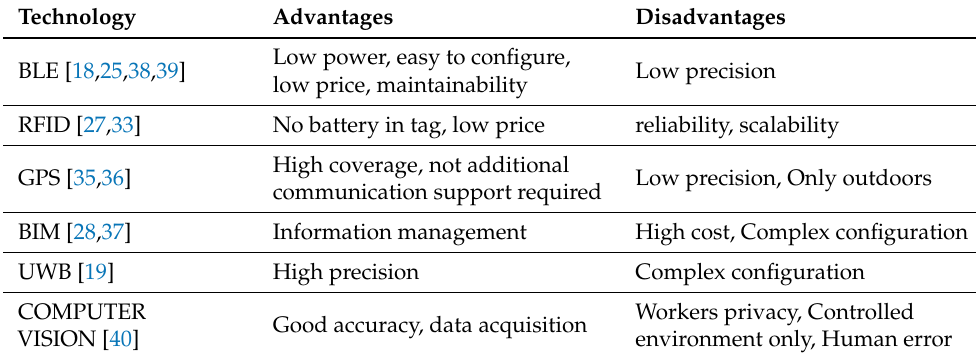
Table 1. Comparison of location technological